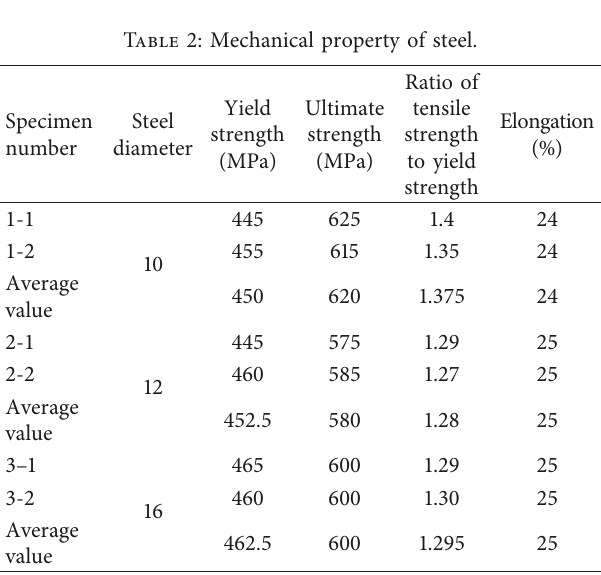
Table 2: Mechanical property of steel.